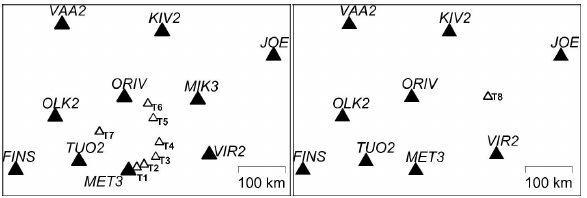
Figure 3: Test points and reference station configurations for inter- polation tests. FinnRef stations are marked with black triangles. On the left hand side are the test points T1-T7 where the complete FinnRef network was active. On the right hand side is the Mikkeli test point T8 where the nearest FinnRef station (MIK3) was deac- tivated for the measurements. For geographical location compare with Fig. 2.